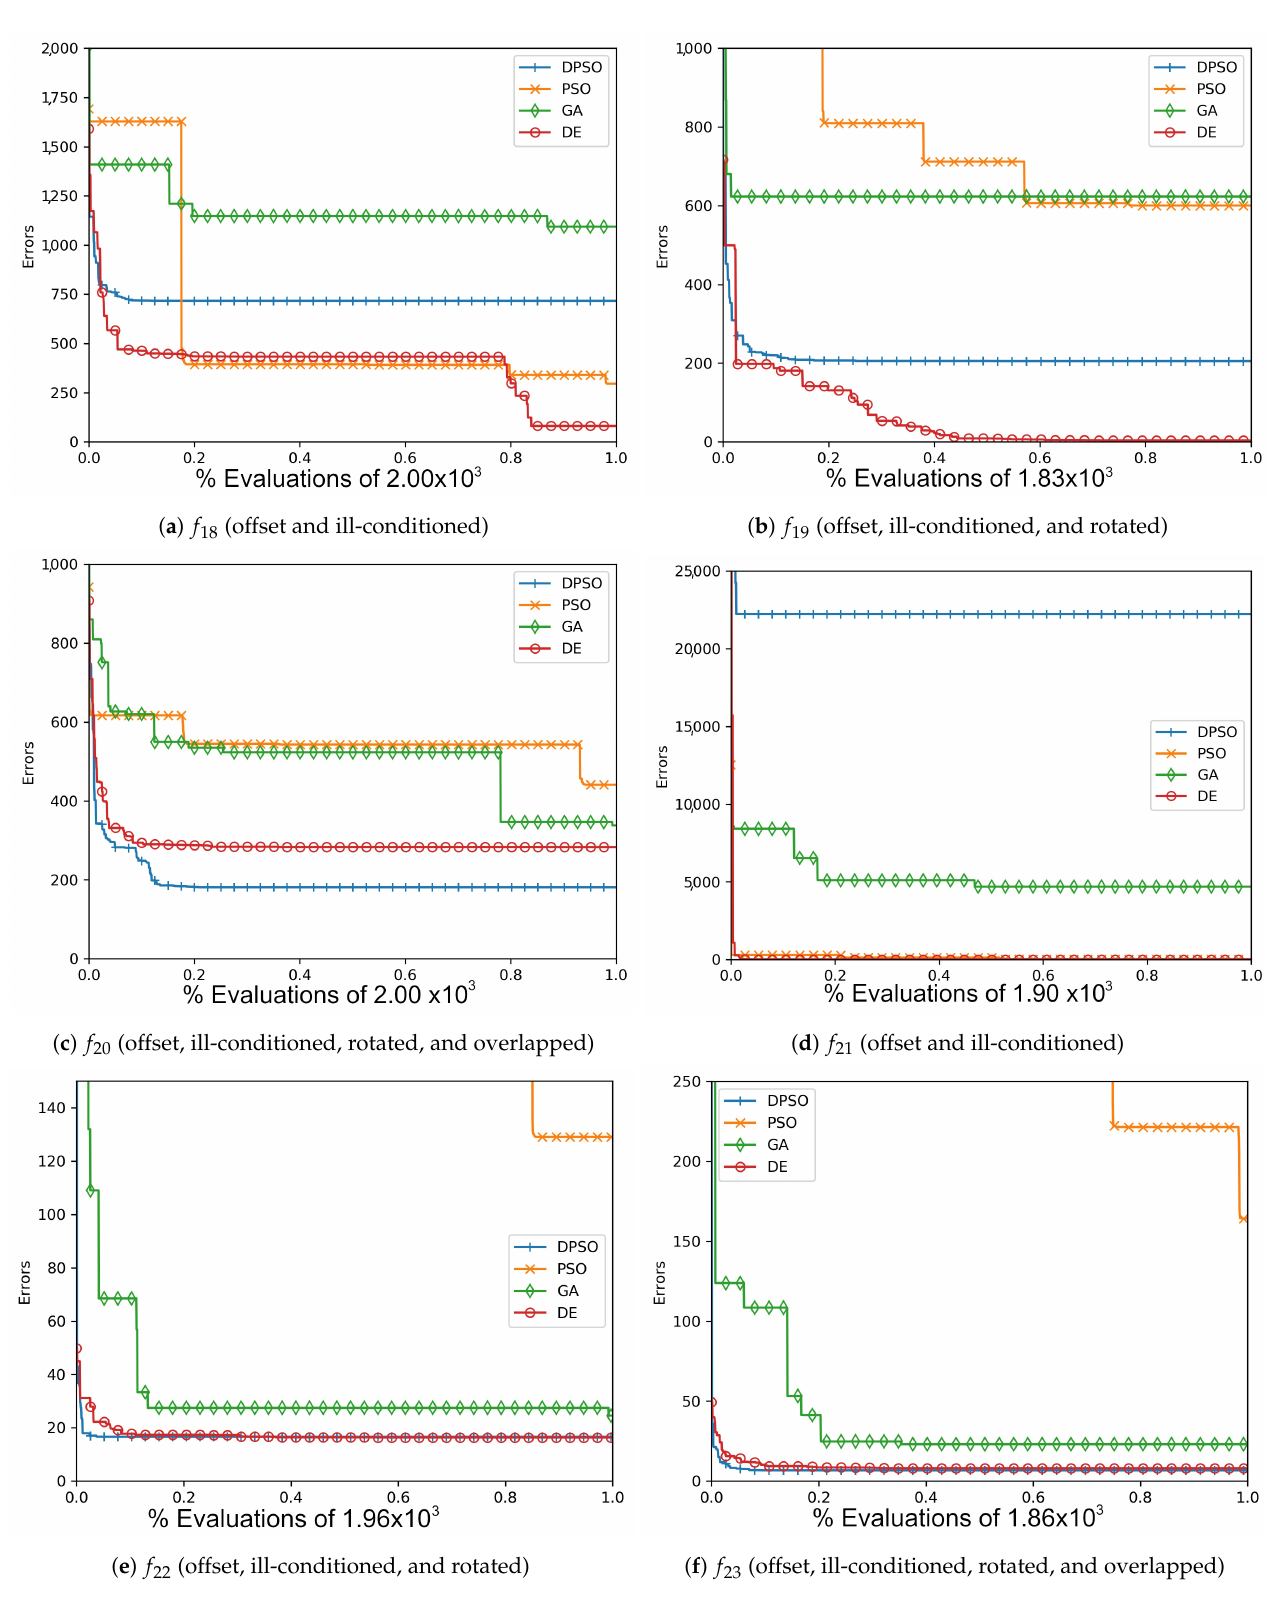
Figure A10. The average Zero-Sum ( f 18 , f 19 , f 20 ) and Salomon ( f 21 , f 22 , f 23 ) global best results over time for 7